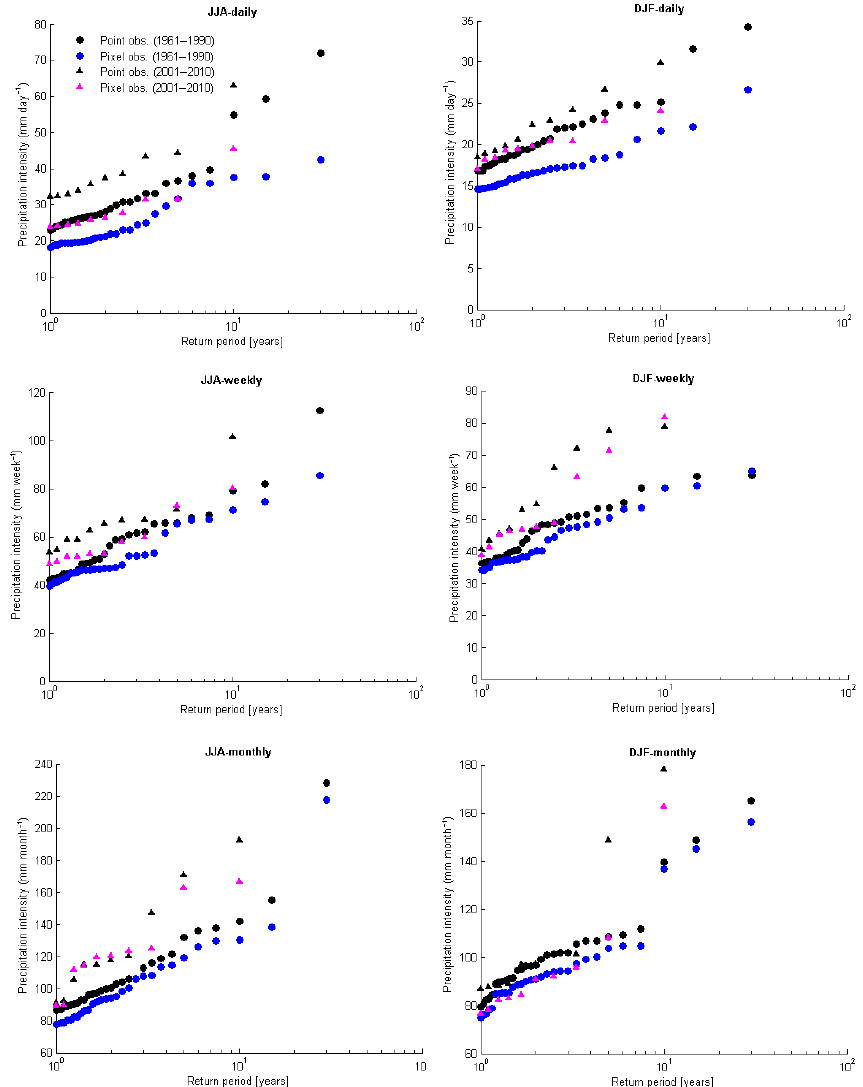
Figure 2. Comparison between point and pixel interpolated (spatial resolution of 27.8km) Uccle precipitation of different timescales for summer (left-column panels) and winter (right-column